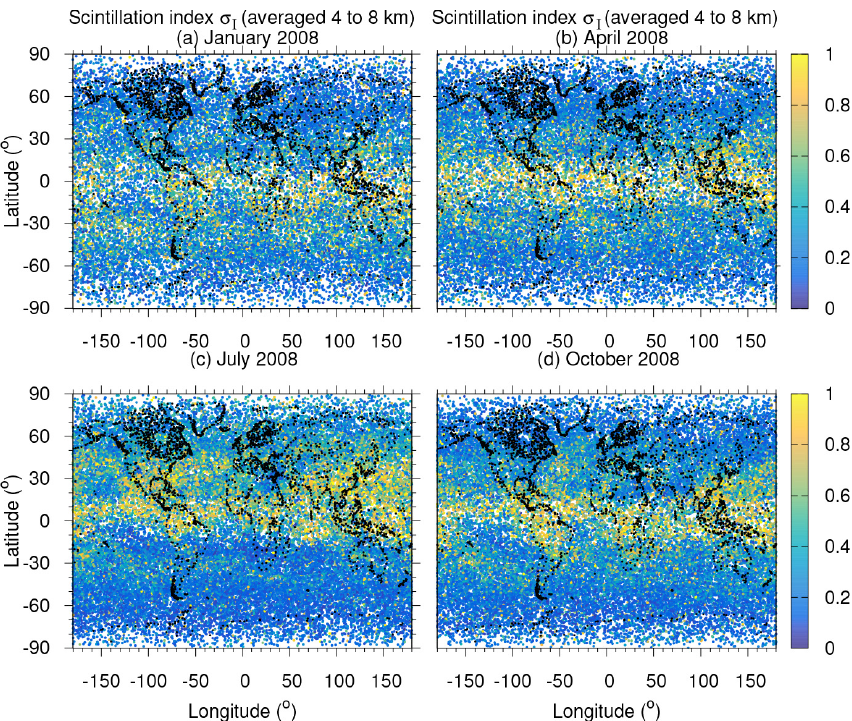
Figure 2. Global map of altitudinal average (4–8km altitudes) scintillation index derived from the COSMIC RO data for January, April, July, and October 2008.